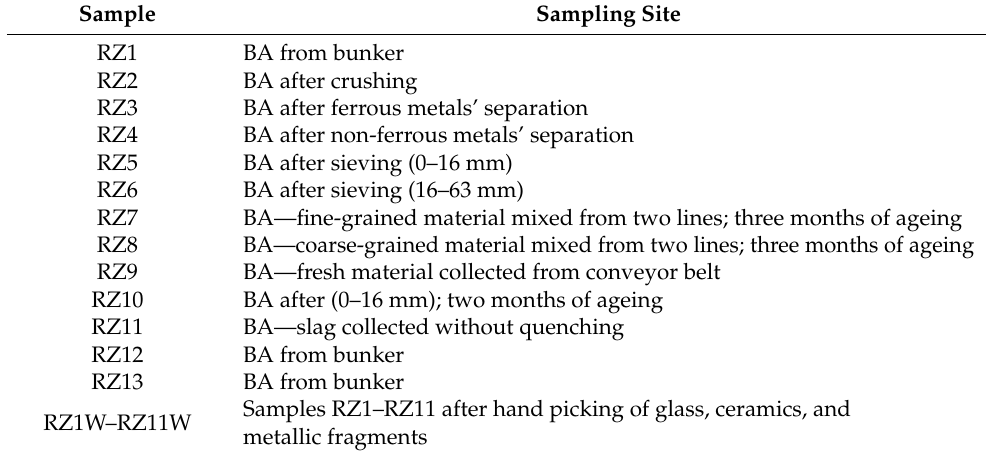
Table 1. List of the studied